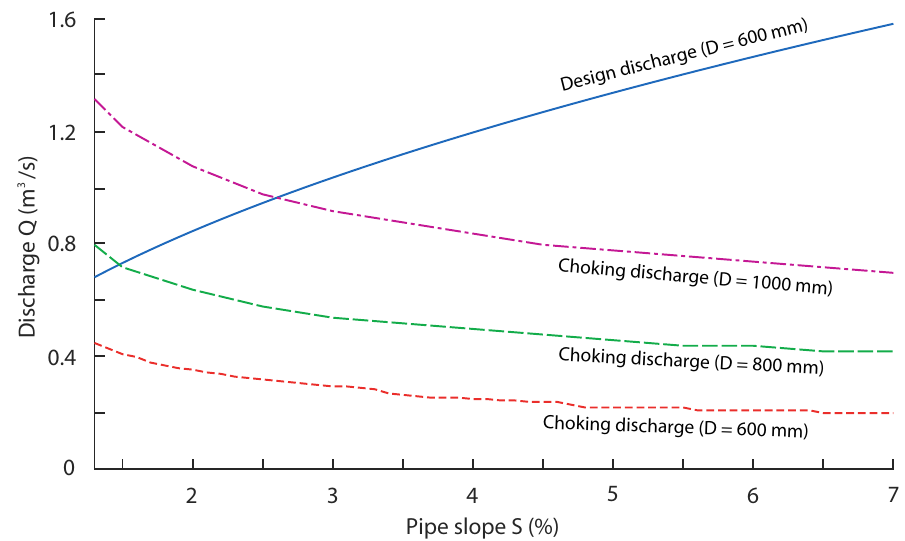
Figure 12. Solutions of uniform flow discharge as a function of pipe slope, and limits to the design discharge Q for choking-free flow. Manning‘s roughness coefficient is n =